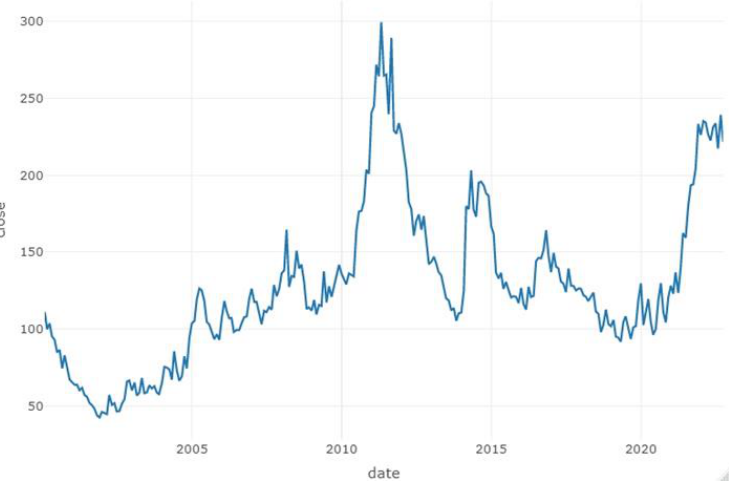
Figure 2. Trend of coffee price in ICE Futures US. Own processing based on data from Yahoo Finance.